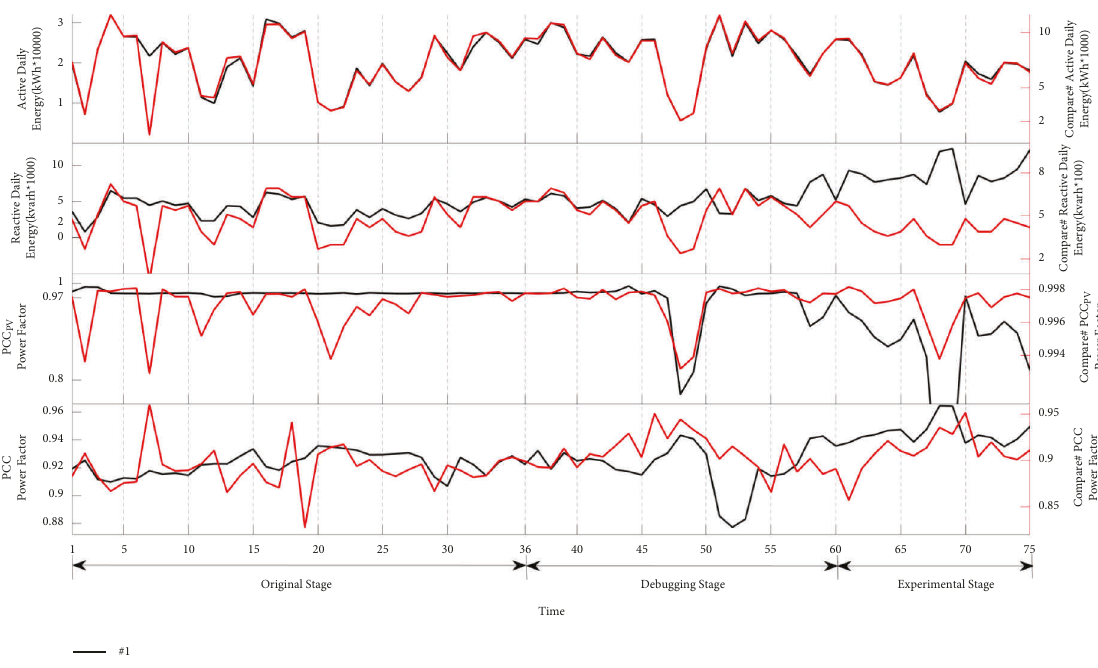
Figure 14: Control experiment daily diagram of PVPS under RPC.